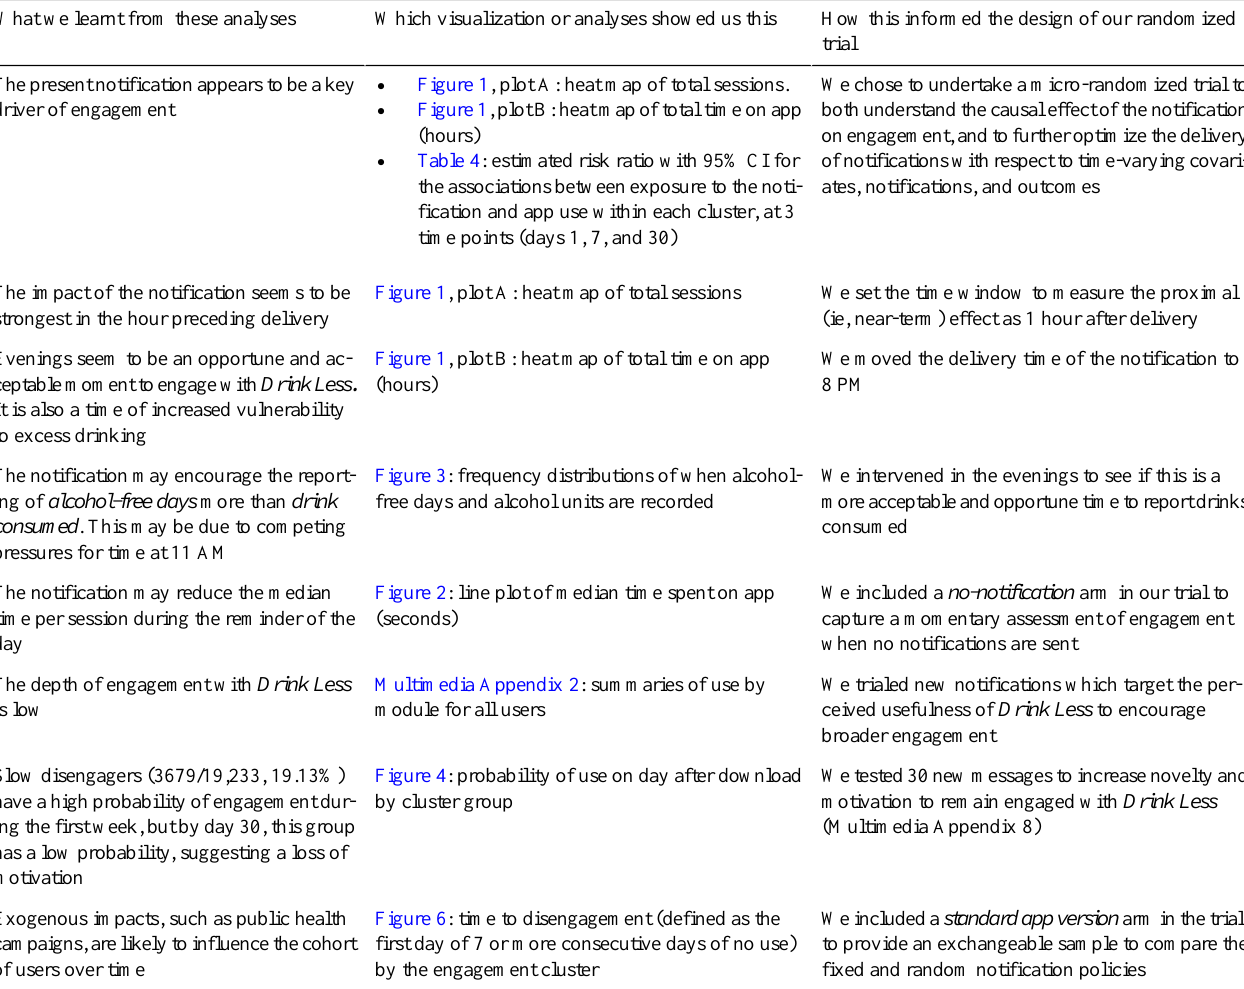
Table 5. Linking visualization to the design of a micro-randomized trial.